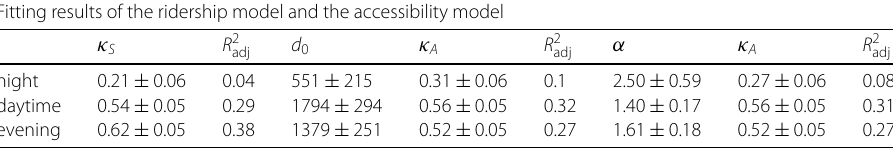
Table 1 Fitting results in the ridership model and the accessibility model, given by Eqs. (6) and (7), values of the ridership model are presented in the first and second columns, respectively. κ S and R 2 adj respectively. The third and fourth columns present the obtained values of κ A and d 0 of exponential are shown in the fifth column. accessibility, respectively, while the corresponding values of R 2 adj